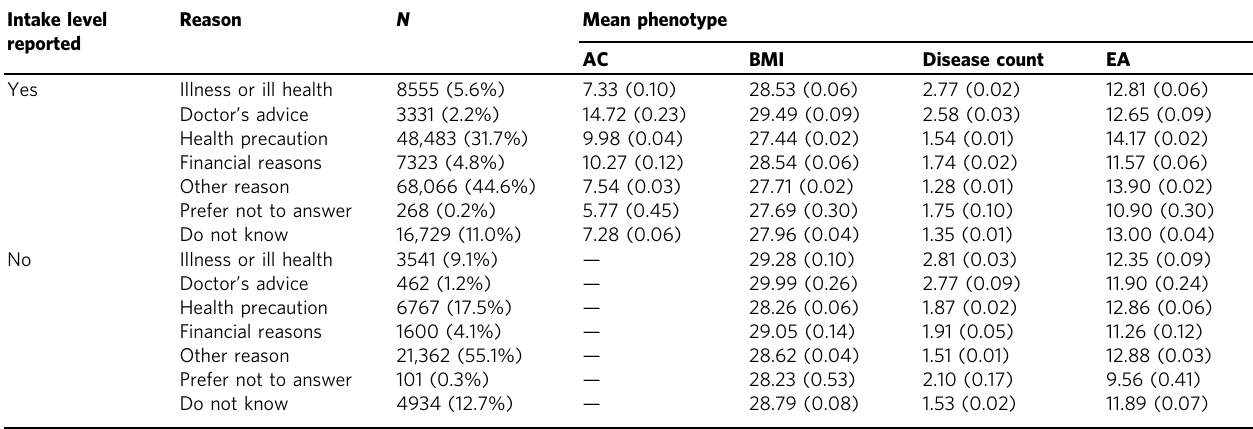
Table 2 Descriptive statistics of the reasons for reducing alcohol intake.